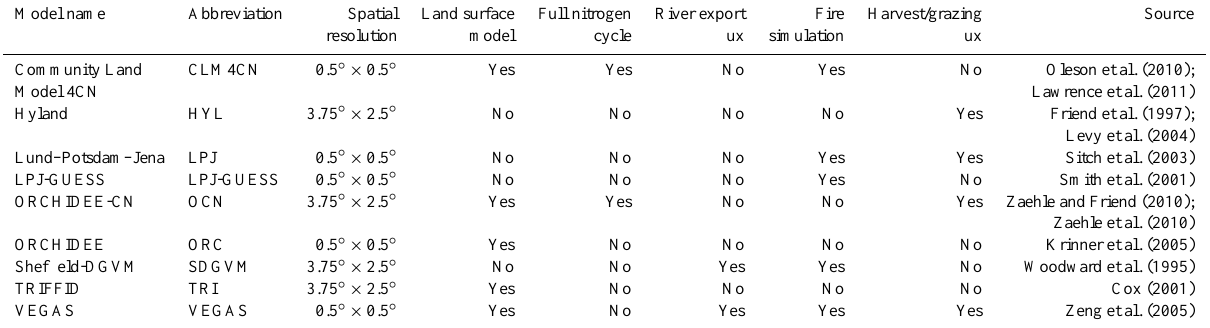
Table 1. Characteristics of the nine dynamic global vegetation models.